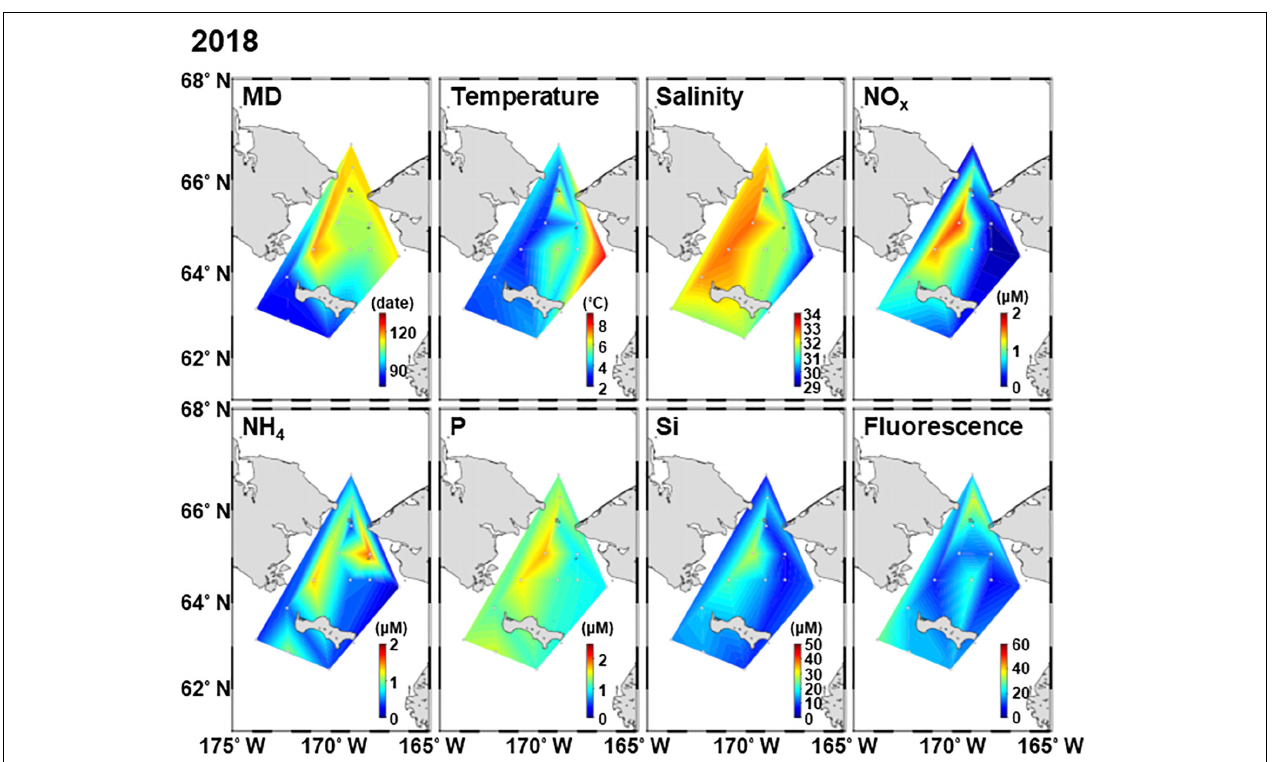
FIGURE 3 | Horizontal distribution of environmental factors in the northern Bering Sea during 2–12 July 2018. MD, melt